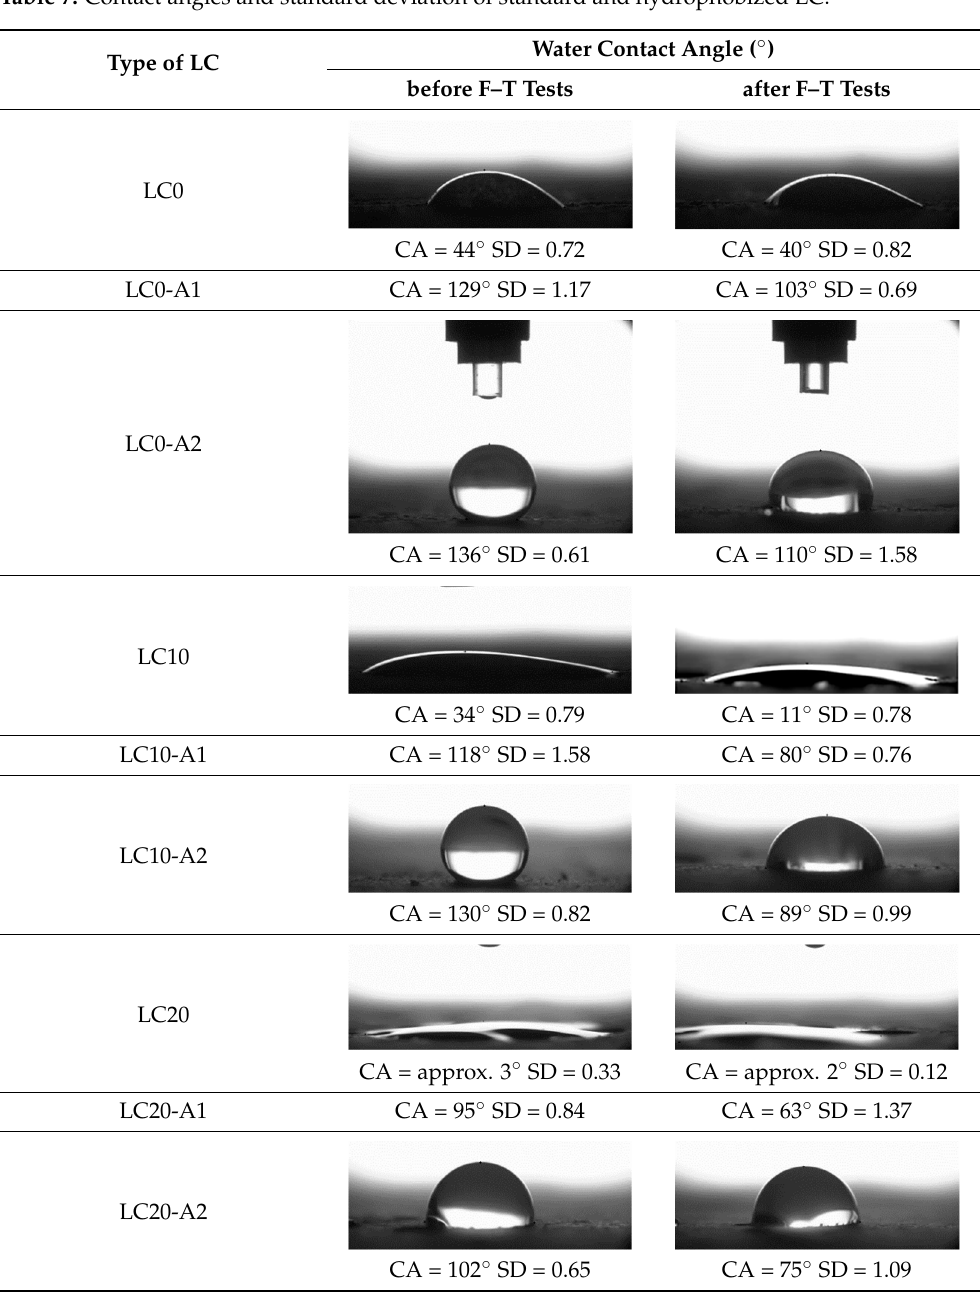
Table 7. Contact angles and standard deviation of standard and hydrophobized LC.